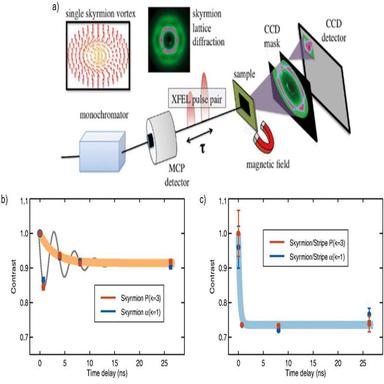
a) Schematic experimental setup for the 2-pulse XPCS at LCLS in Stanford. The insets show the spin texture of a single skyrmion vortex and the hexagonal X-ray diffraction pattern reminiscen of a skyrmion lattice. b), c) Contrast as a function of delay time between the two consecutive pulses for the skyrmion lattice phase (b) and the skyrmion stripe phase (c) showing a remarkable change in the decay times of the contrast. Reprinted from M. Seaberg et al, Phys Rev Lett 119 067,403 (2017).